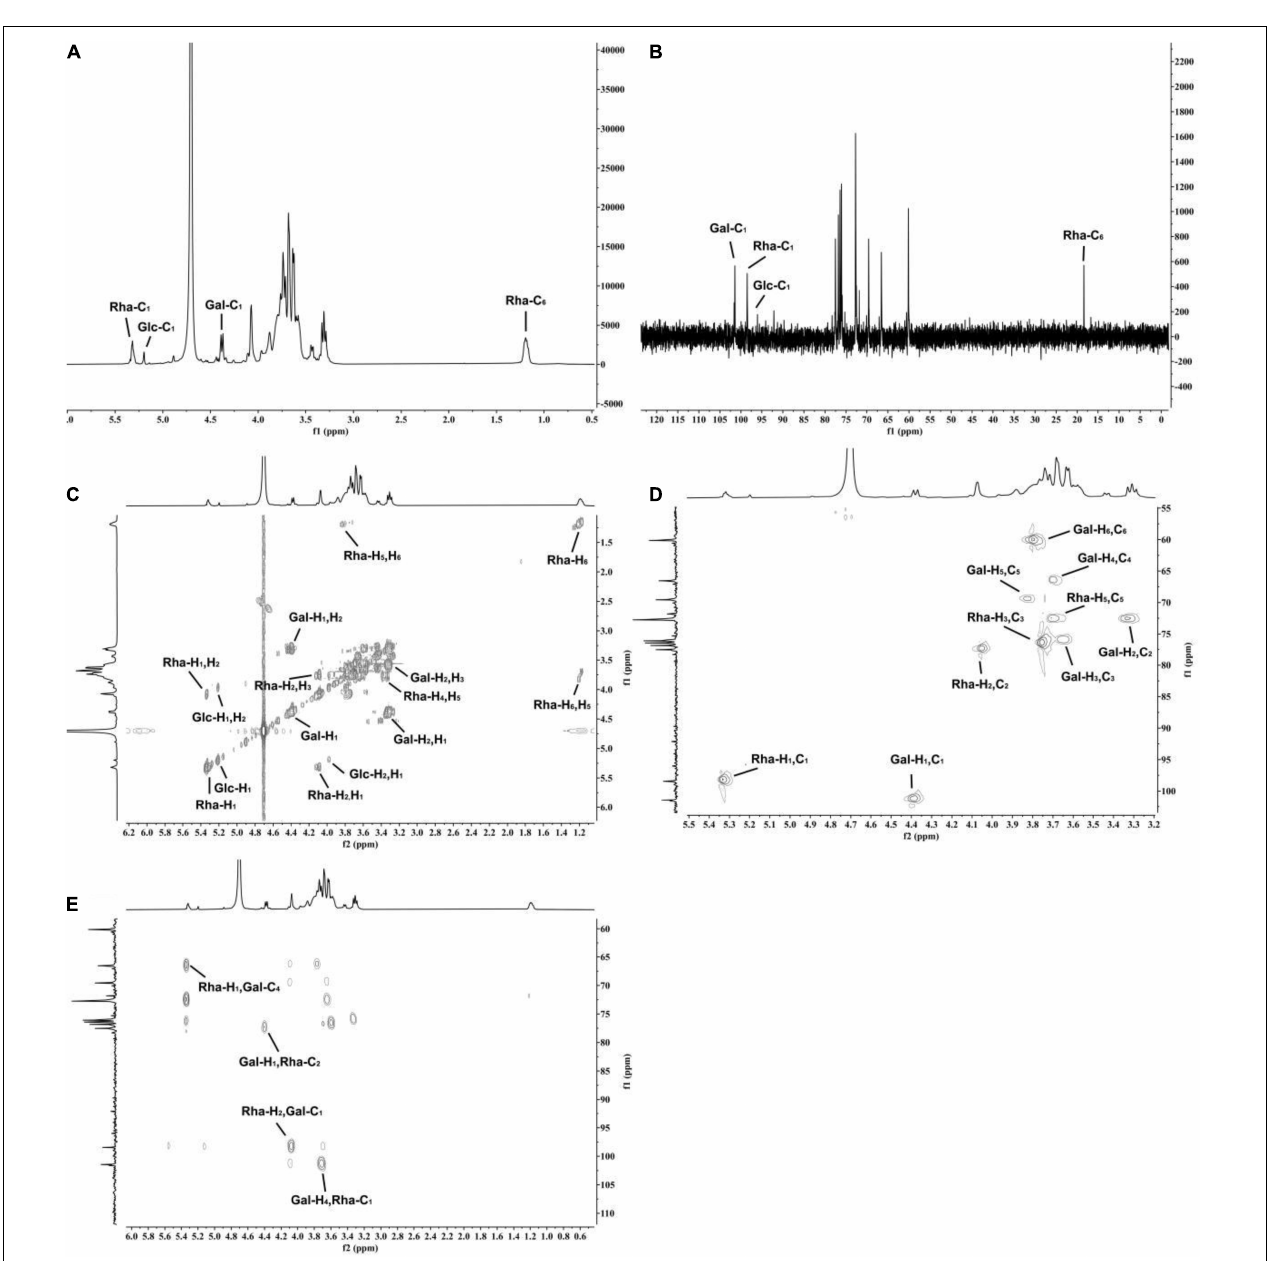
FIGURE 5 | The NMR spectroscopy of polysaccharide K-CMLP. 1 H NMR (A) , 13 C NMR (B) , 1 H- 1 H COSY (C) , 1 H- 13 C HSQC (D) , and 1 H- 13 C HMBC (E) .